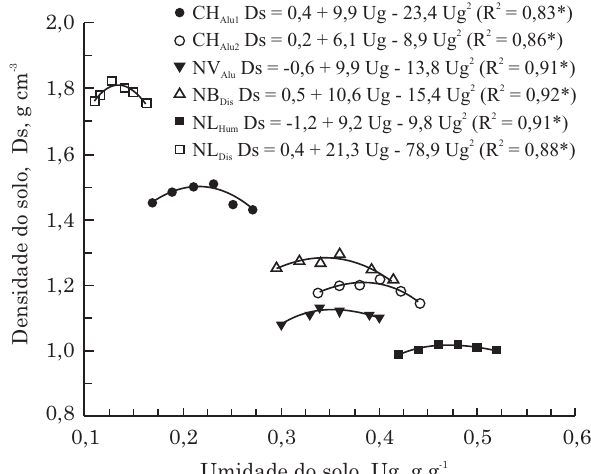
Figura 2. Curvas de compactação do horizonte A de seis solos do Planalto Sul Catarinense pelo ensaio de Proctor Normal. CH Alu1: Cambissolo Húmico alumínico 1; CH Alu2 : Cambissolo Húmico alumínico 2; NV Alu : Nitossolo Vermelho alumínico; NB Dis : Nitossolo Bruno distrófico; NL Hum : Neossolo Litólico húmico, NL Dis : Neossolo Litólico distrófico. * : significativo (0,01<p<0,05) e ** : significativo (p<0,01) pelo teste